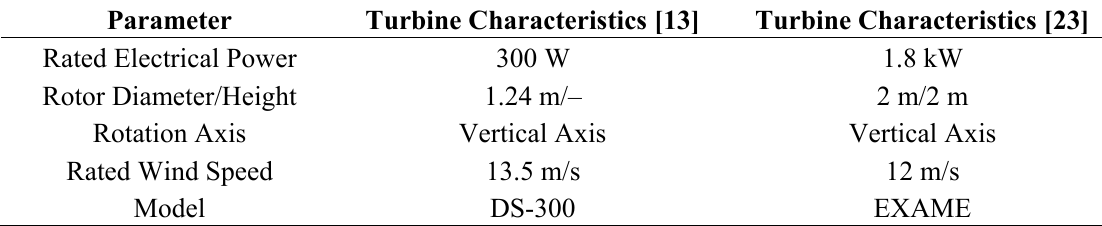
Table 7. Technical specifications of a small-scale WT.